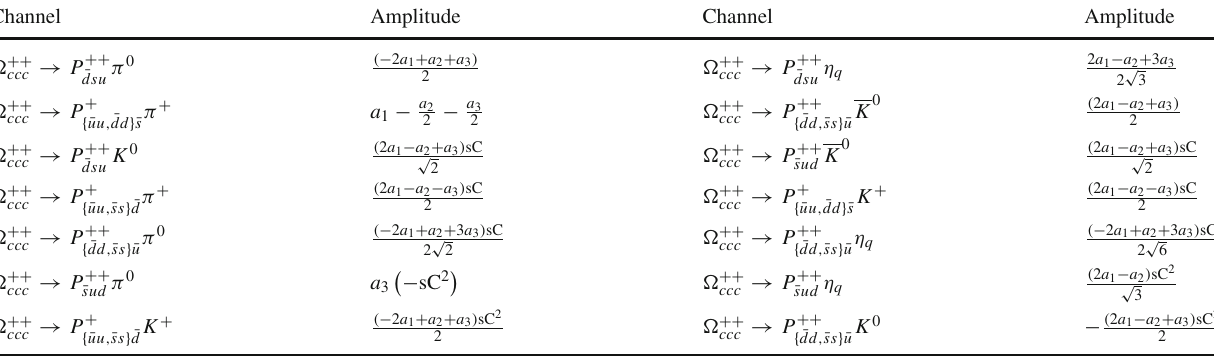
Table 2 The production of pentaquark P 6 ( cc ¯ qqq ) from triply heavy baryon (cid:2) ccc , sC represents the overall CKM factor sin (θ C ) Channel Amplitude Channel Amplitude